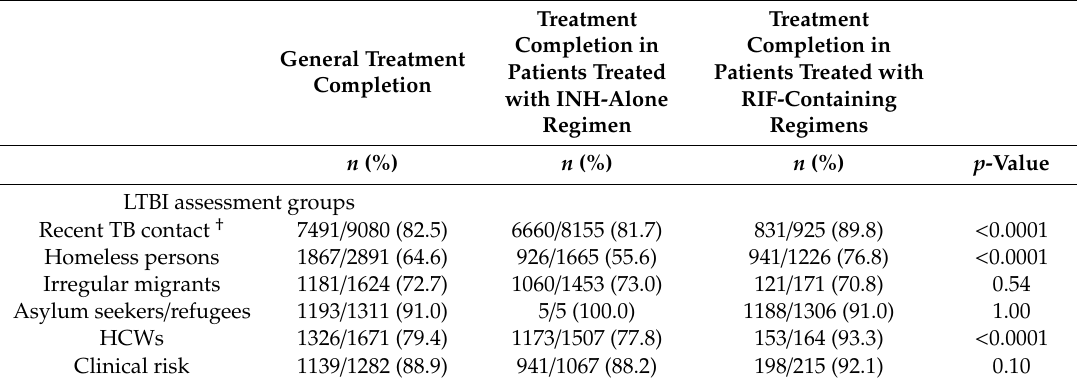
Table 4. Comparison of treatment completion rates between in individuals without treatment changes ( n =